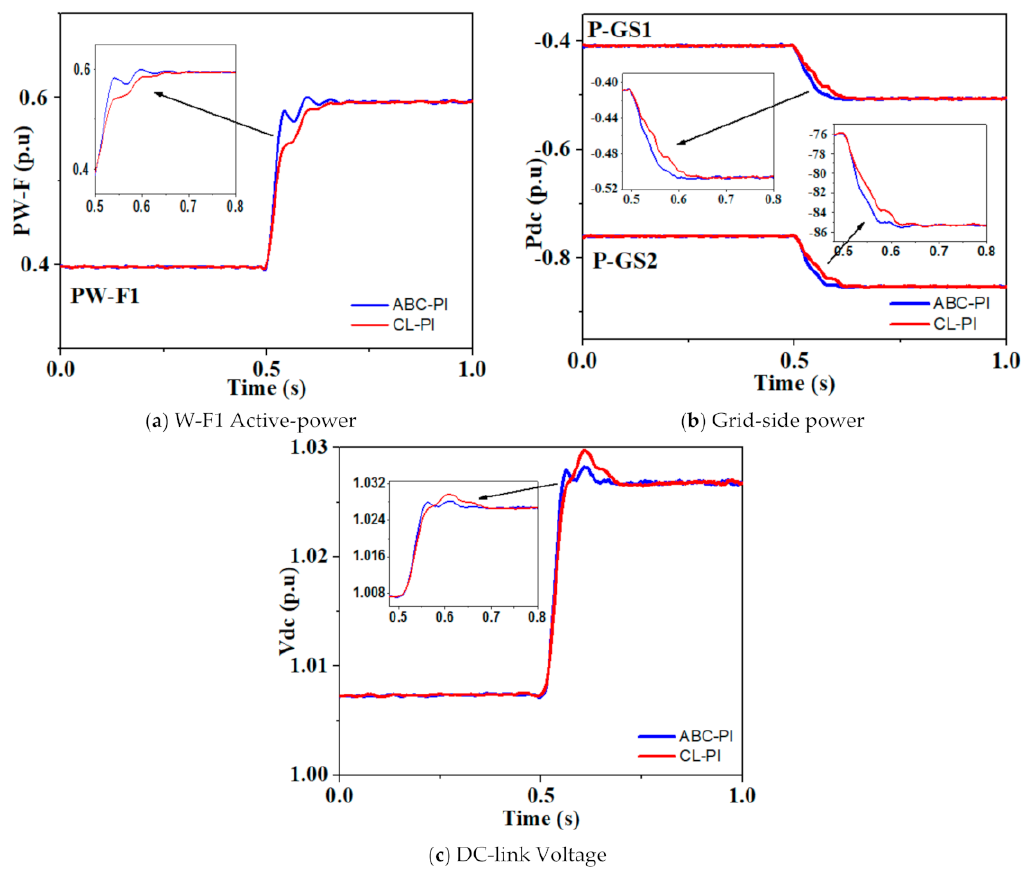
Figure 13. ( a ) W-F1 Active-power, ( b ) grid-side power, ( c ) DC-link voltage during unbalance wind power generation at